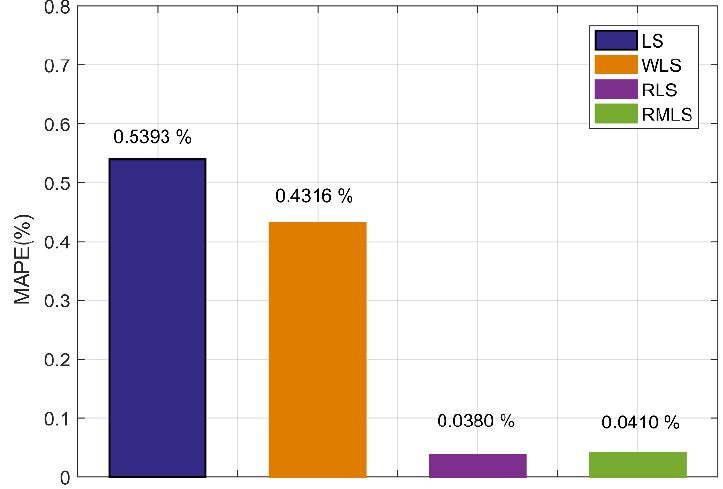
Figure 11. MAPE of four algorithms of 10,000 Monte Carlo simulation experiments at x = 50 cm.